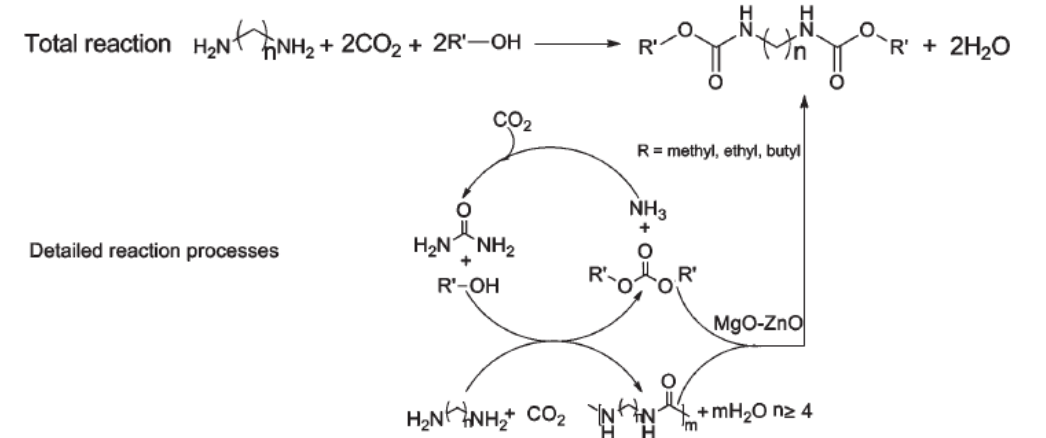
Figure 39. Synthesis of N-substituted dicarbamates from diakyl carbonates and polyurea derivatives based on diamines and CO 2 . From reference [48].